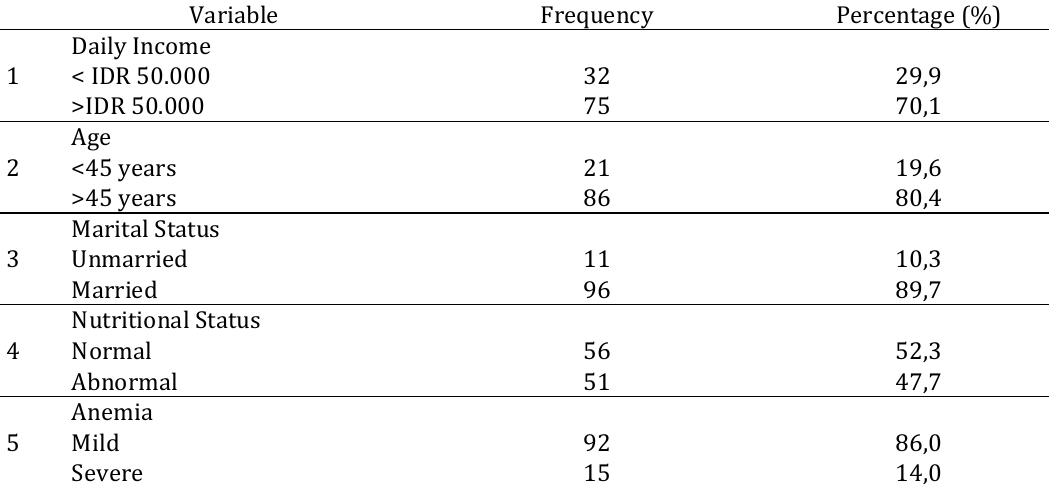
Univariate Analysis Result